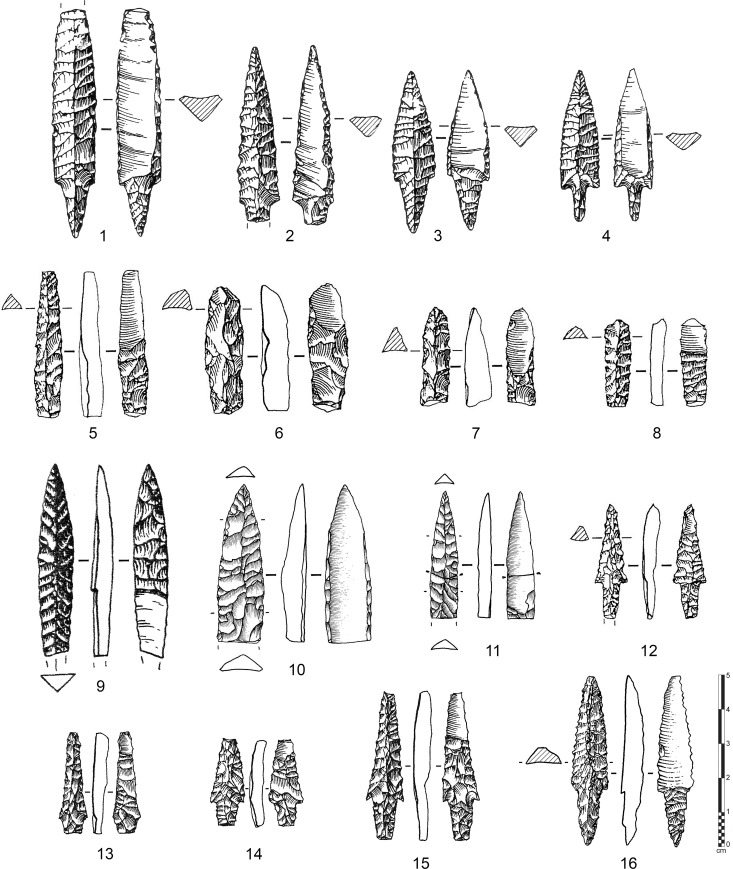
Various types of fluted points from Yemen and Oman.1–4: Abr 1/3 site, Yemen ([112]: 143; [5]: 41); 5–8: Mahdi site, Yemen ([5]: 42); 9: Habarut site, Yemen ([101]: 227); 10,11: Gravel Bar Site, Yemen ([113]: 120); 12: Khor al-Hajar KHJ-1, Oman ([5,108]); 13–16: Suwayh SWY-1 site, Oman ([105]: 55).